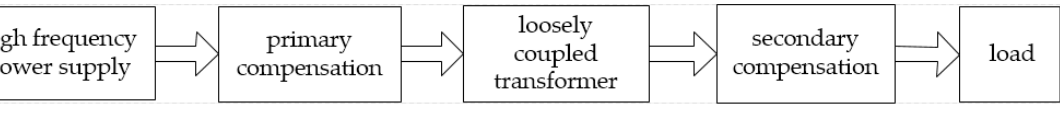
Figure 4. Structure diagram of the ICPT system simulation.